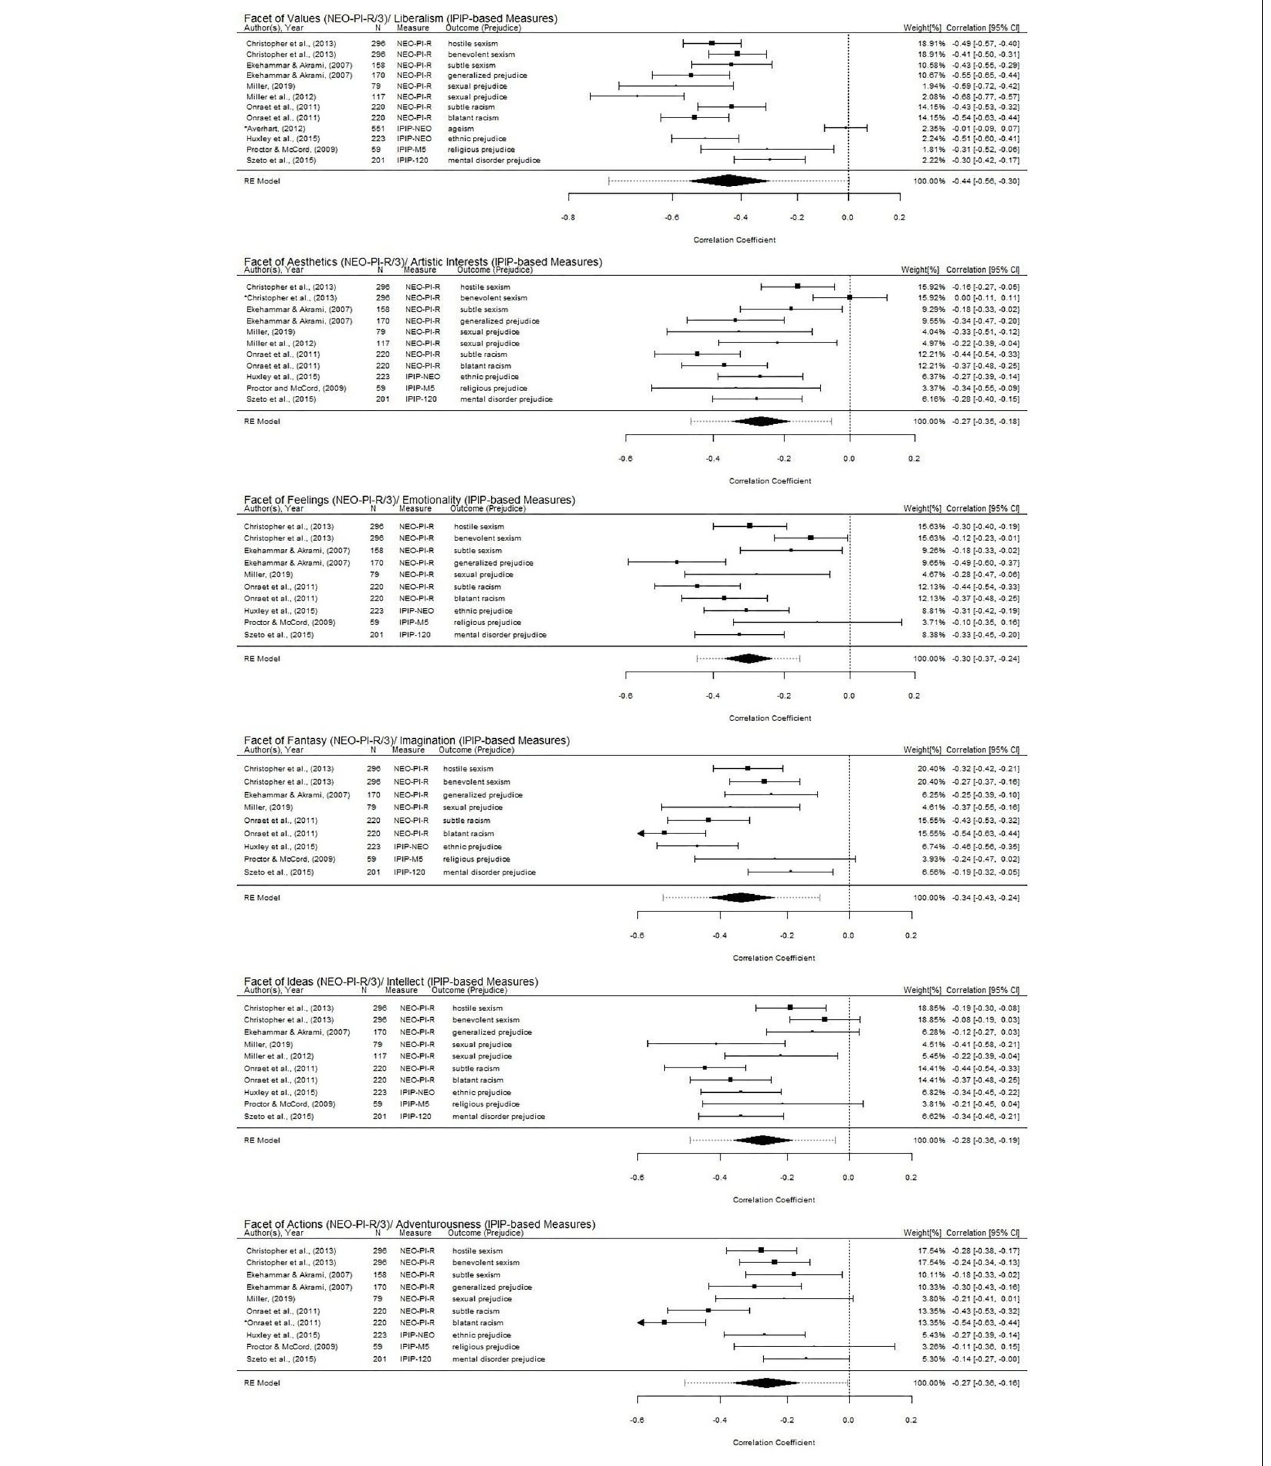
FIGURE 3 | Forest plots for the associations of the facets of openness with prejudice. The summary effect sizes are displayed as a polygon at the bottom of each plot with the width reflecting the 95% confidence interval of the average effect size estimate. The dotted line extending from the polygon reflects the 95% prediction interval which accounts for both the uncertainty of the effect size estimate and the uncertainty in the between-study variance estimate (Riley et al., 2011). Studies with larger squares contributed more to the summary effect sizes compared to the other studies. Studies with an asterisk (*) were potential outliers and influential cases as per standardized residual, Cook’s distances, and hat values for each